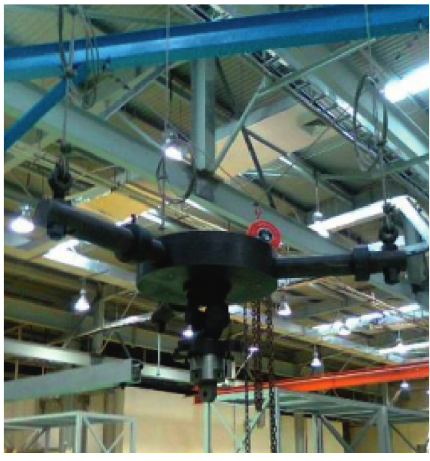
Figure 3: The moment of inertia test bench. Table 1: The moment of inertia and product of inertia of a powertrain (kg · m 2